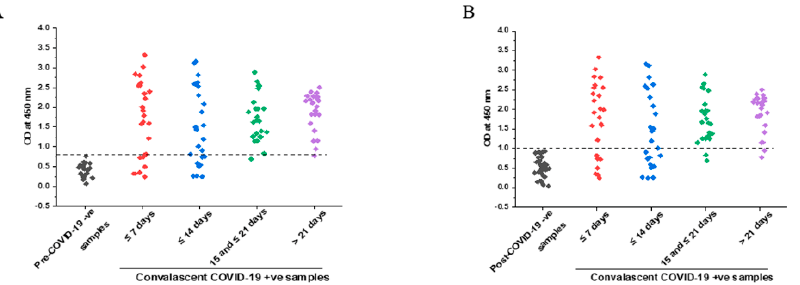
Figure 4. IgG response against PRAK-03202 in ( A , B ) COVID-19-positive convalescent samples at the indicated periods of symptoms onset and negative samples from ( A ) pre-COVID-19 and ( B ) post-COVID-19 era. - - - - indicates the cut-off